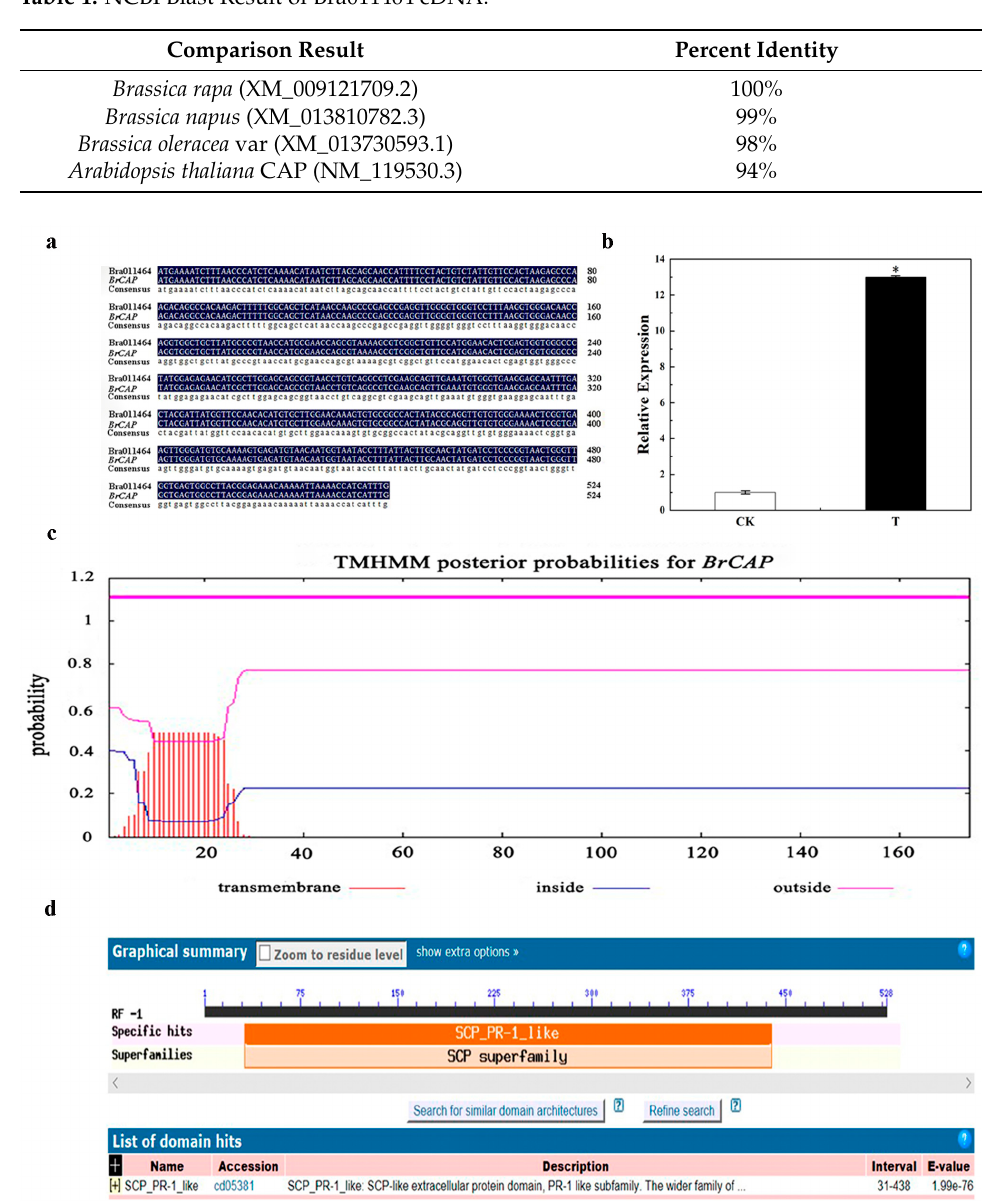
Table 1. NCBI Blast Result of Bra011464 cDNA.